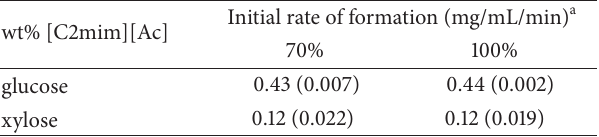
Table 2: Initial rates of fermentable sugar formed during hydrolysis ofsafflowerwholeseeds.Initialhydrolysisrateswerecalculatedfrom the data obtained during the first 10 minutes of hydrolysis.